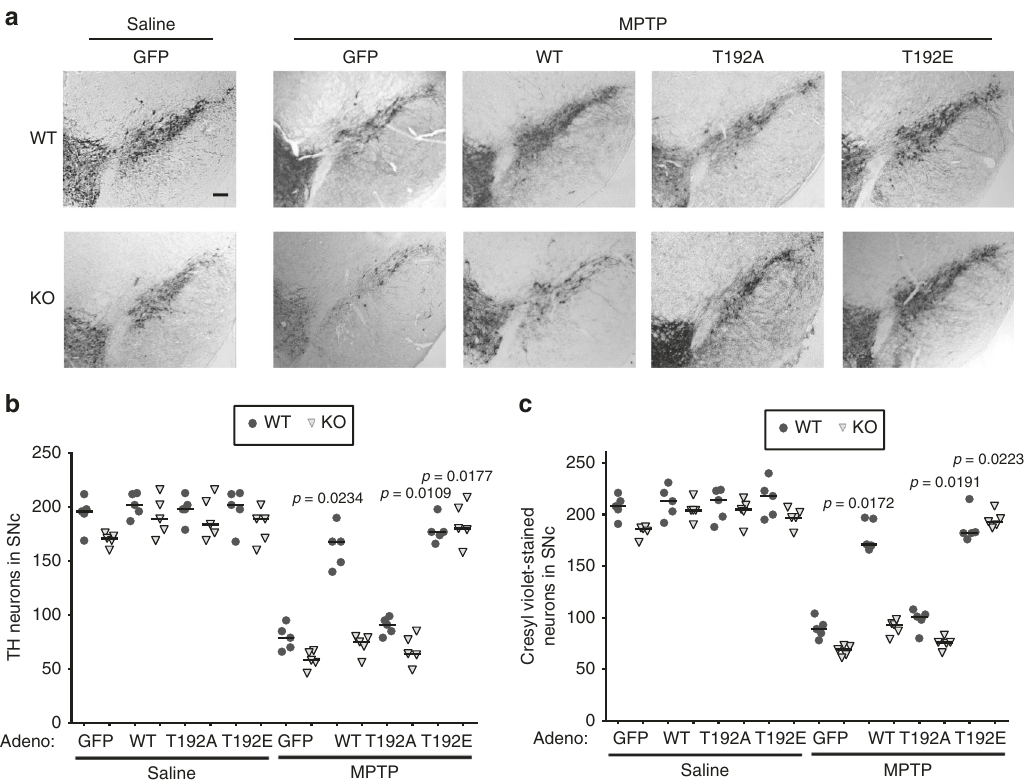
Fig. 6 The protective role of phospho-LETM1 at Thr192 in MPTP-injected mice. a Representative images of the ipsilateral side in PINK1 WT and KO mice injected with corresponding AdGFP, LETM1-WT, T192A, and T192E viruses as indicated with saline or MPTP injected 1 week later. Scale bar: 100 µ m. b Quanti fi cation of TH-positive dopaminergic neurons from ipsilateral sides in the indicated groups. n = 5. c Quanti fi cation of cresyl violet-stained neurons at the ipsilateral sides from the indicated treatment groups. n =